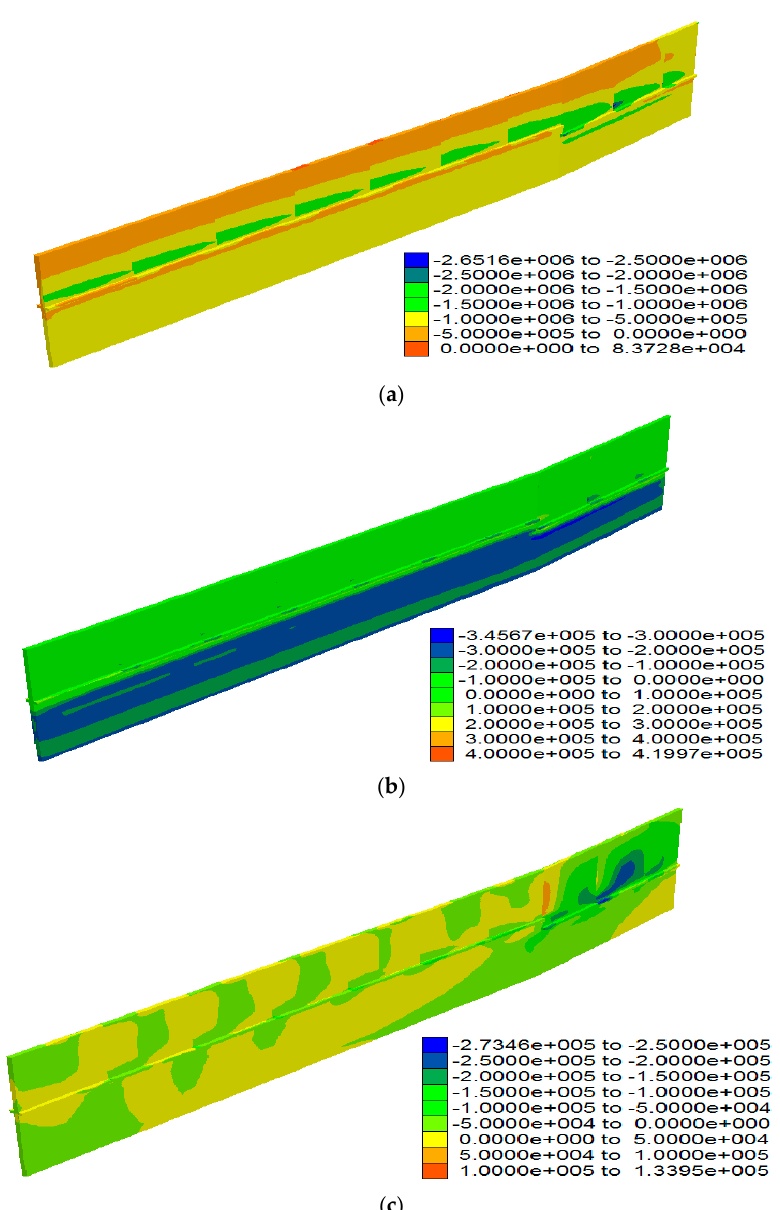
Figure 19. Schematic diagram of overall stress distribution of the cut-off wall. ( a ) Nephogram of maximum principal stress. ( b ) Minimum principal stress nephogram. ( c ) Nephogram of shear stress in YZ plane of the cut-off wall.